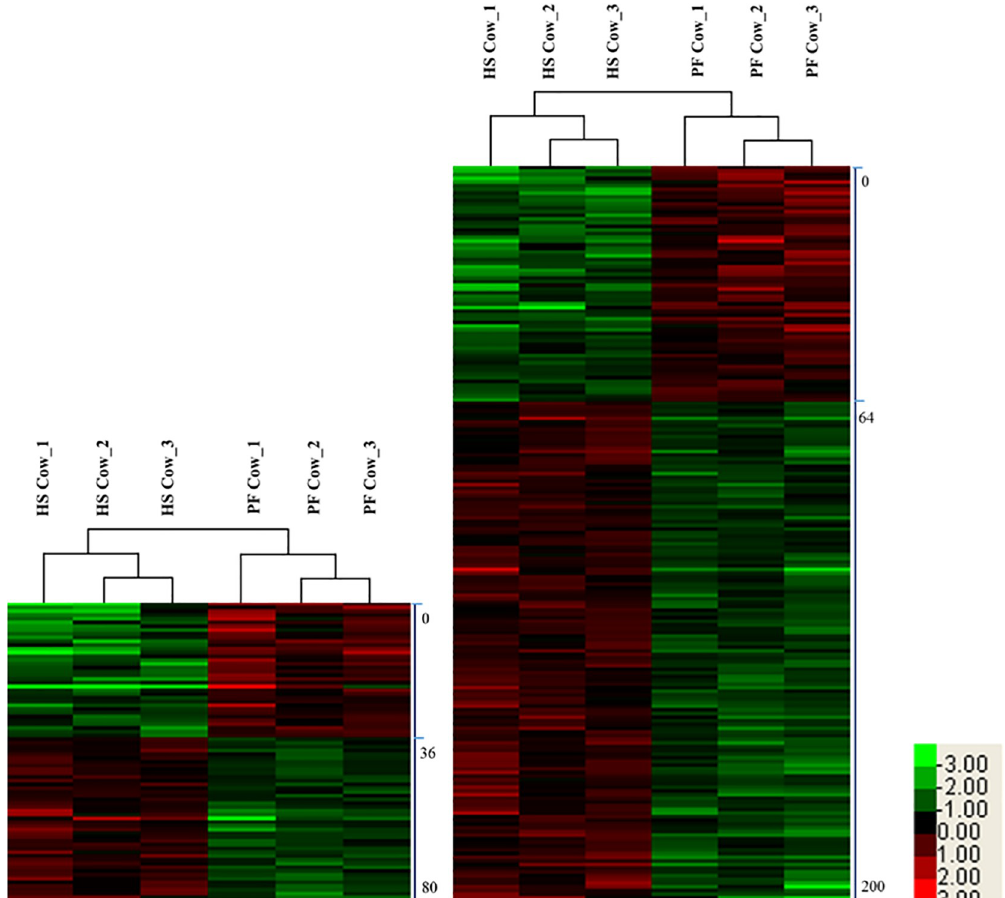
Fig 1. Hierarchical clustering of differentially expressed proteins in mammary gland (A) and liver (B) between heat-stressed and pair-fed cows. The bar color represents a logarithmic scale from -3.0–3.0. HS mean heat stress; PF mean pair-fed.